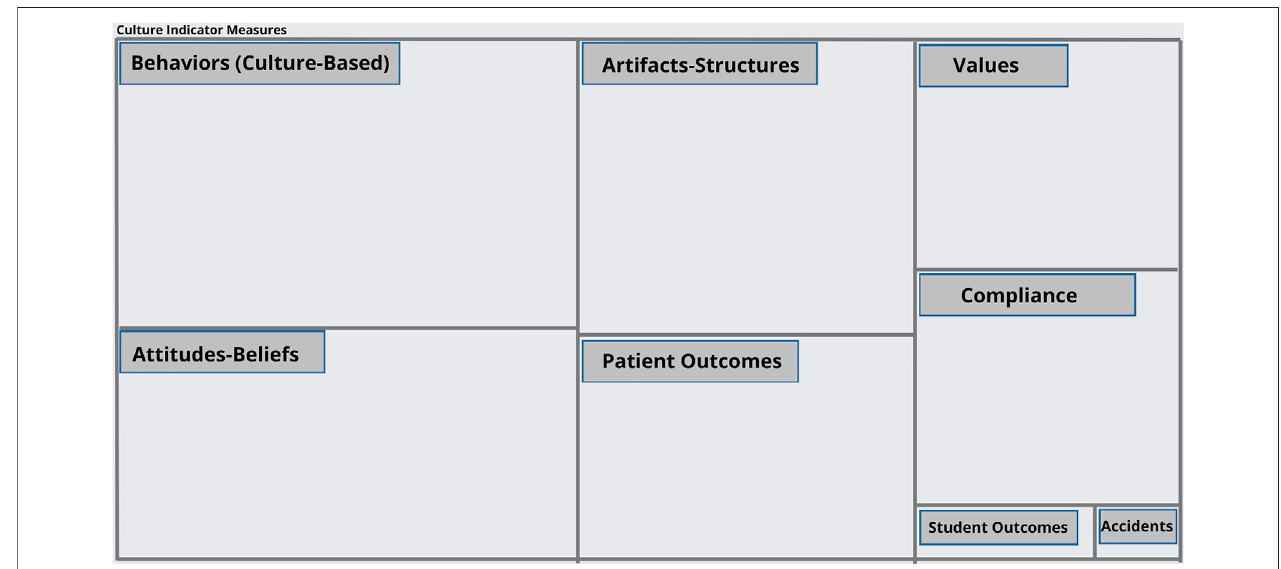
FIGURE 3 | Outcome indicator-measure node tree